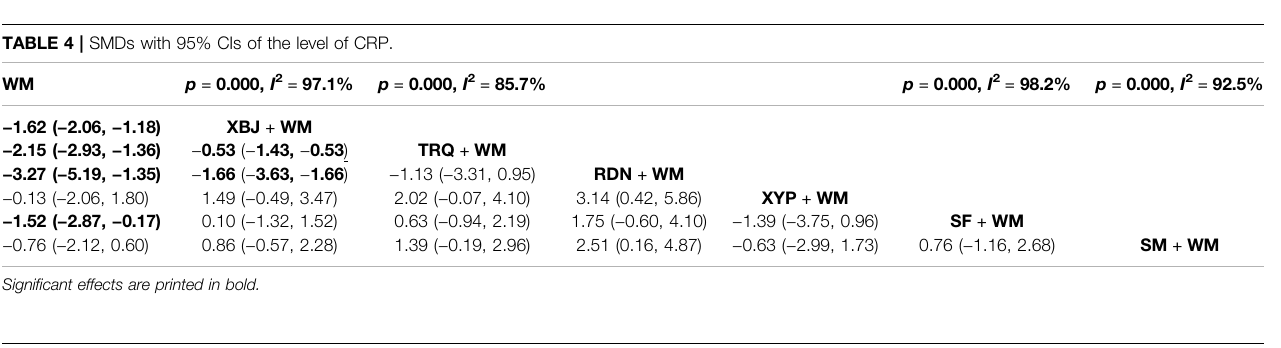
TABLE 5 | SMDs with 95% CIs of the level of PCT. WM